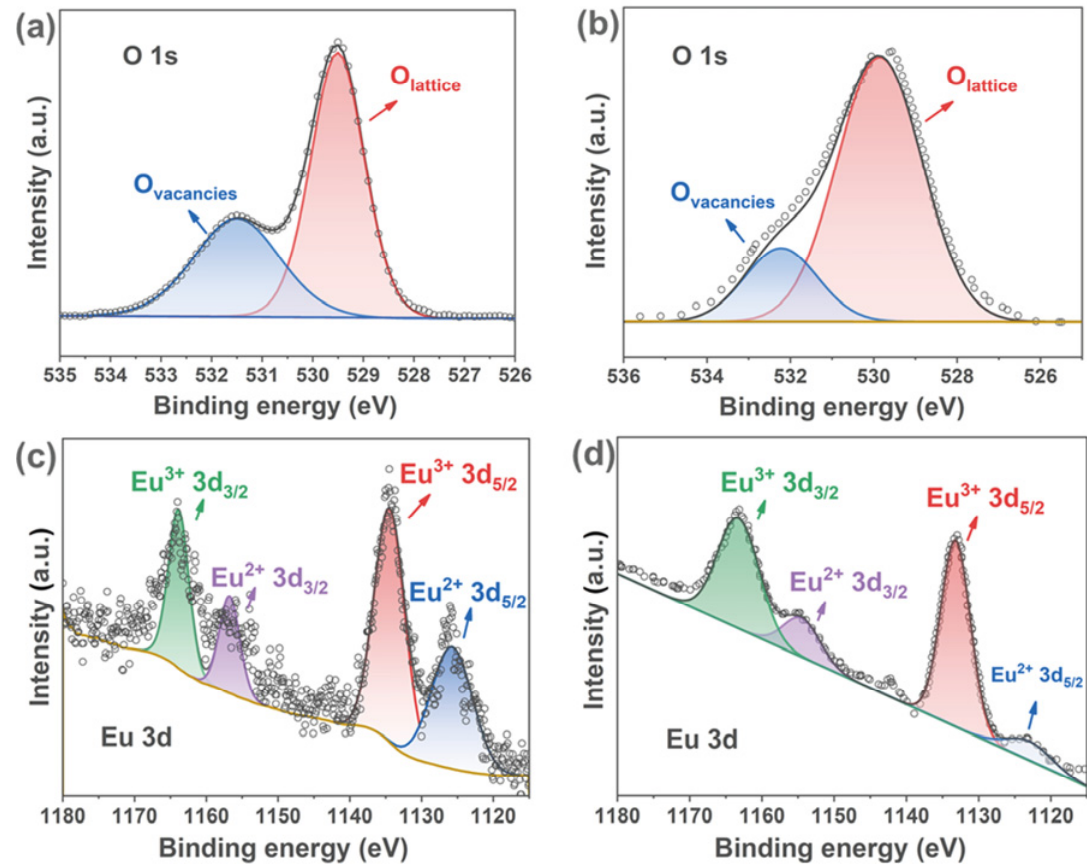
Fig. 6 XPS analysis. (a) O 1s and (c) Eu 3d spectra of HEAO sample and (b) O 1s and (d) Eu 3d spectra of EuAlO 3 sample. Reproduced with permission from Ref. [53] for (b, d), © Elsevier B.V.